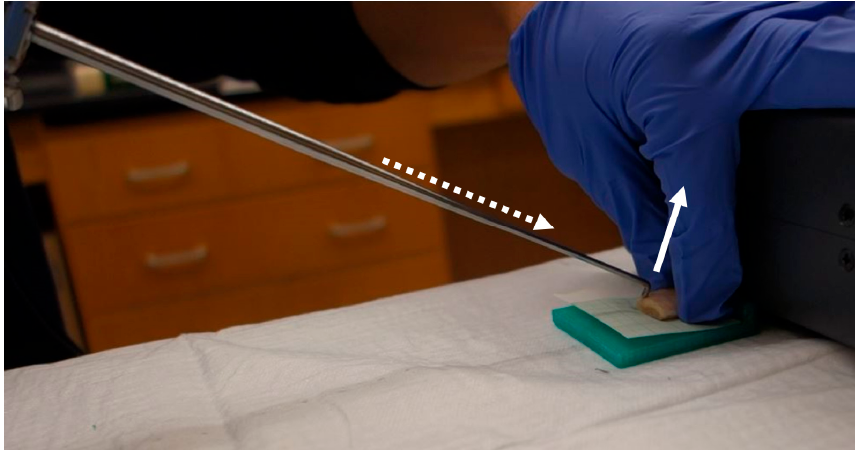
Figure 5. The sensor on the probe measured a reaction force (solid white arrow indicates its direc- tion) on the cartilage surface while manually sliding the probe with 3 mm forward (white dotted arrow indicates its direction).